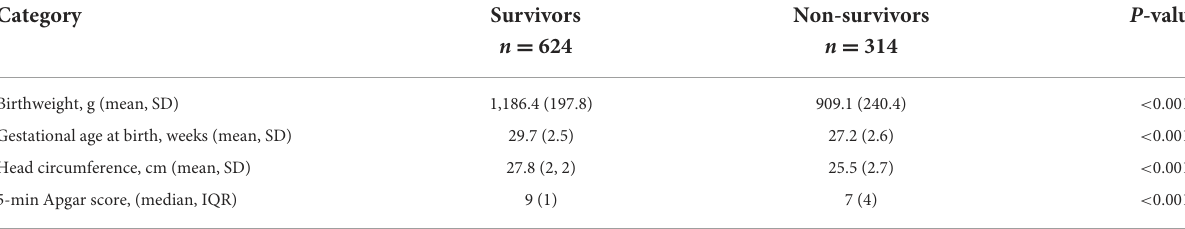
TABLE 2 Infant characteristics comparing survivors to